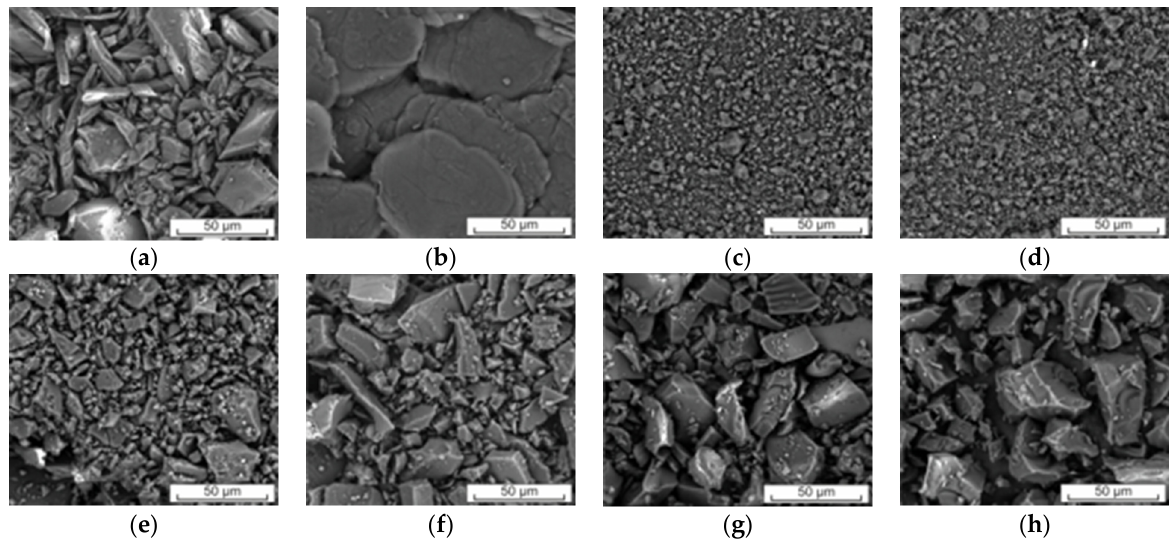
Figure 2. Scanning electron microscopy images of SA ( a ), LYS ( b ), co-amorphous system of SA with LYS in molar ratio 1:1 obtained by ball milling ( c ), co-amorphous system of SA with LYS in molar ratio 1:2 obtained by ball milling ( d ), co-amorphous system of SA with LYS in molar ratio 1:1 obtained by solvent evaporation ( e ), co-amorphous system of SA with LYS in molar ratio 1:2 obtained by solvent evaporation ( f ), co-amorphous system of SA with LYS in molar ratio 1:1 obtained by freeze drying ( g ), co-amorphous system of SA with LYS in molar ratio 1:2 obtained by freeze drying ( h ).